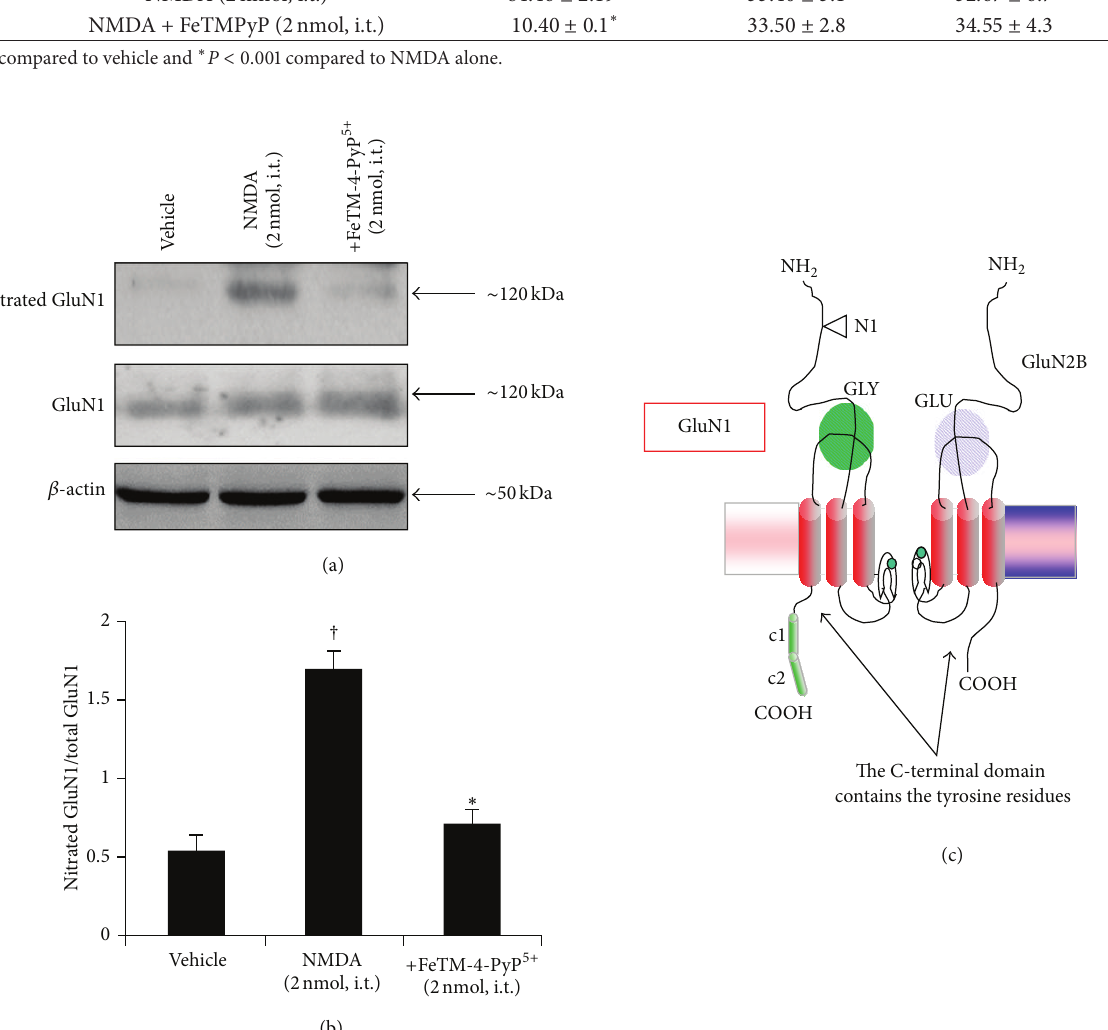
Figure 2: Inhibition of NMDA-induced hyperalgesia by FeTM-4-PyP 5+ is associated with the inhibition of spinal protein nitration ((a)– (c)). As shown by immunoprecipitation, at the time of maximal NMDA mediated hyperalgesia (40min), nitration of GluN1 was observed at the level of the spinal cord ((a), (b)). FeTM-4-PyP 5+ (2nmol given 15min before NMDA) attenuates spinal GluN1 nitration ((a), (b)). Immunoprecipitation data shown in (a) are representative of at least 6 gels from 3 different animals performed on different days. Bar graph in (b) represents quantification by densitometric analysis. No difference for GluN1 or 𝛽 -actin expression was detected among the lanes in these conditions. † 𝑃 < 0.001 compared to vehicle and ∗ 𝑃 < 0.001 compared to NMDA